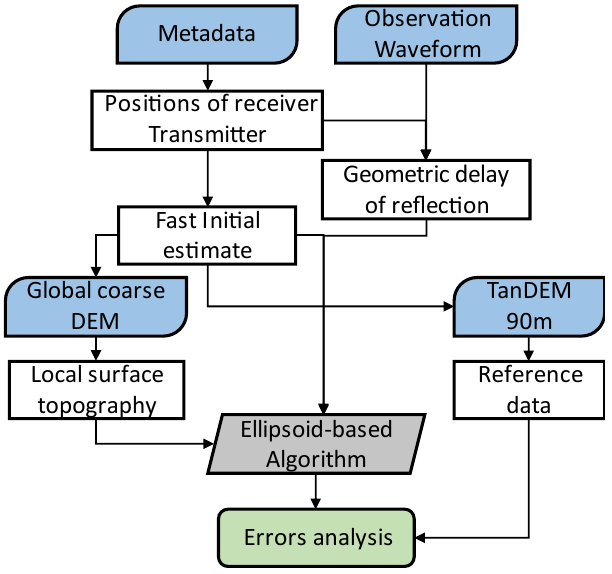
Figure 7. Workflow of data processing.